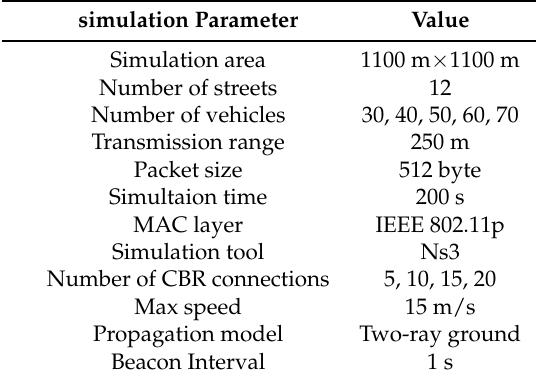
Table 3. Simulation